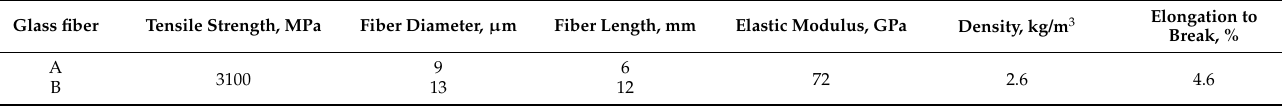
Table 3. Physical and mechanical properties of